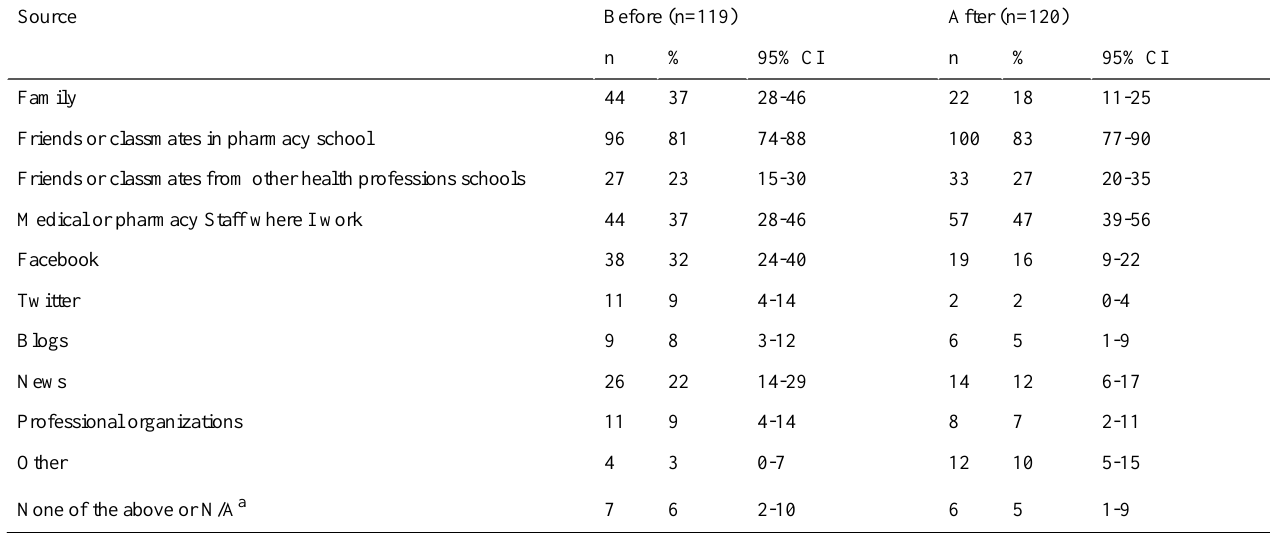
Table 3. Responses regarding where students learn about new apps, before and after the learning